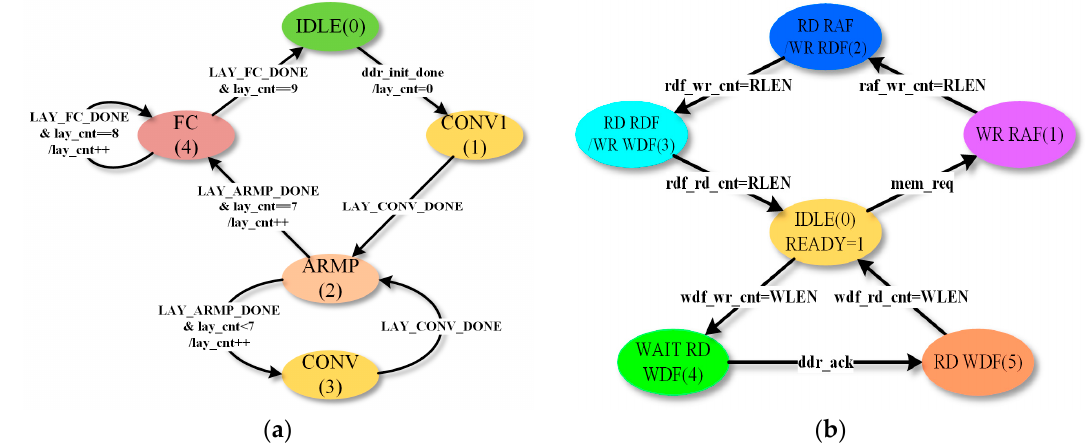
Figure 7. Control modules design. ( a ) State transition diagram of System controller (SYS_CTRL) module. ( b ) State transition diagram of DDR controller (DDR_CTRL) module.